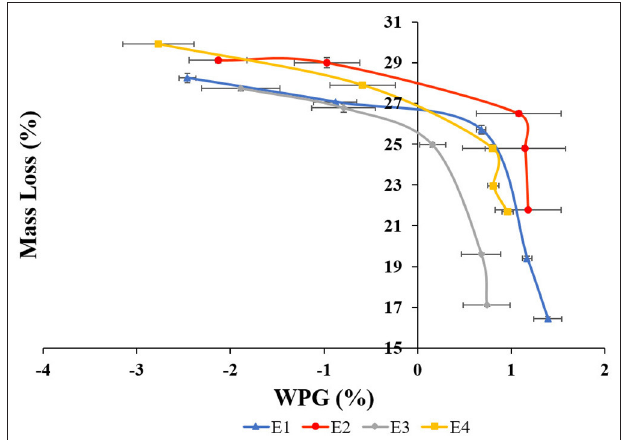
FIGURE 7 | Mass loss concerning weight percent gain (WPG) of Lannea coromandelica wood blocks.